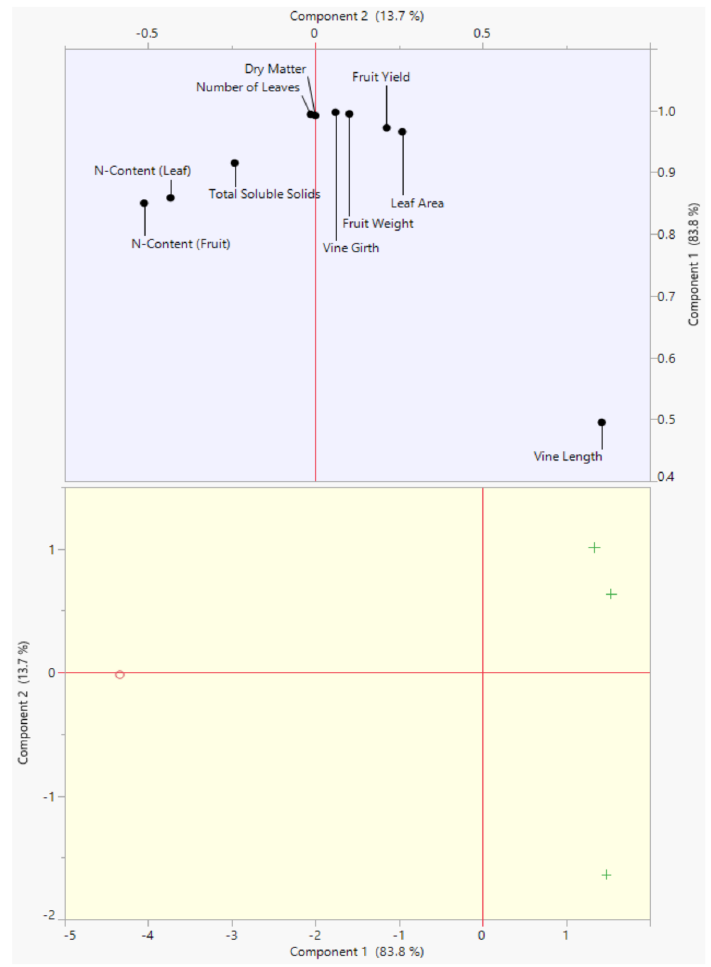
Figure 6. Biplot matrix for principal component analysis revealing the distribution of traits in question under treatments. The upper half of the matrix represents traits, while the lower half depicts treatments placed at different places of the